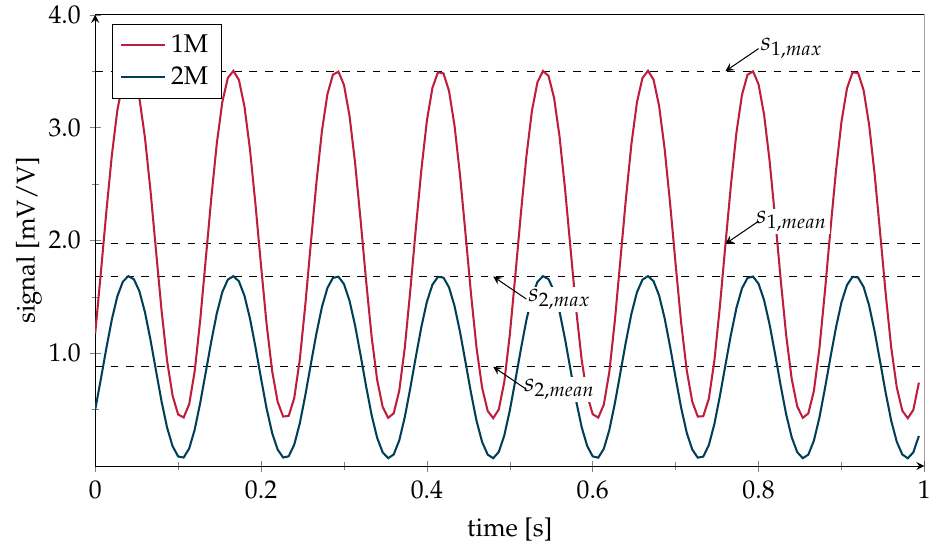
Figure 17. Exemplary sensor signal snapshot starting at 50,400 cycles when crack has Figure 14. Exemplary sensor signal snapshot starting at 50,400 cycles when crack has reached the reached the DSF. While the second row maximum value s 2, max as well as the mean value DSF. While the second row maximum value s 2, max as well as the mean value s 2, mean of sensor 2M remained at their initial values, the first row maximum amplitude s 1, max as well as the mean value s 2, mean of sensor 2M stayed at their initial values, the first row maximum amplitude s 1, max of sensor 1M increased with crack propagation. s 1, max as well as the mean value s 1, max of sensor 1M increased with crack propagation.